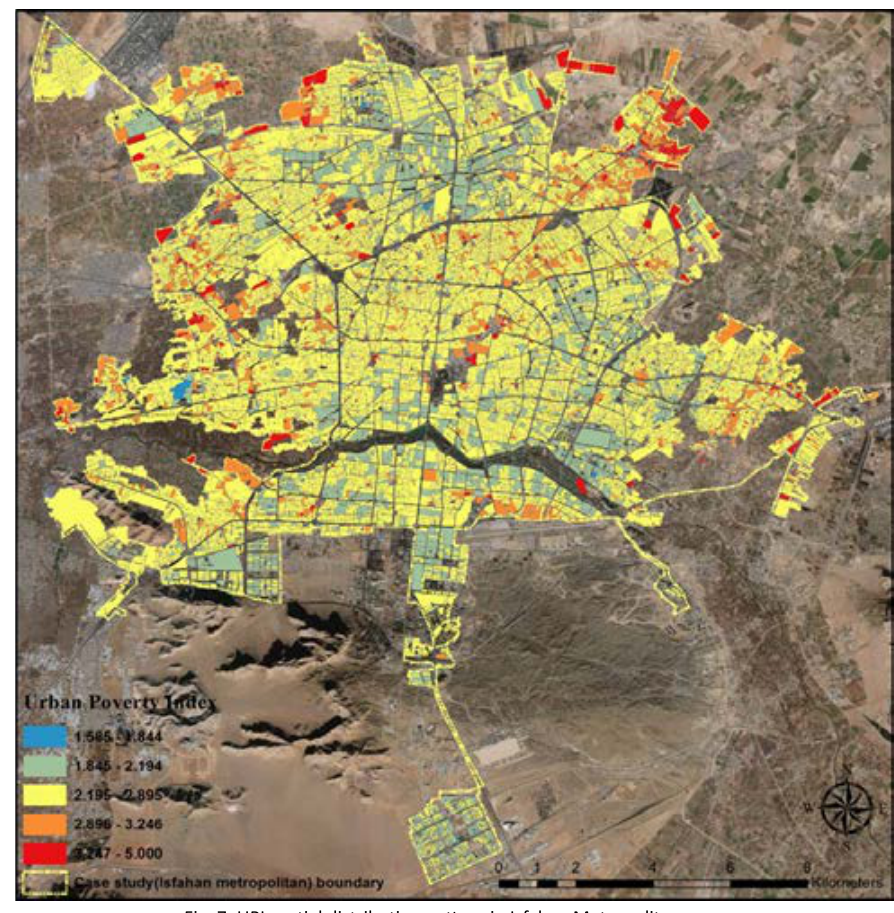
Fig. 7: UPI spatial distribution pattern in Isfahan Metropolitan area Table 4. The condition of urban blocks and population in face of urban poverty